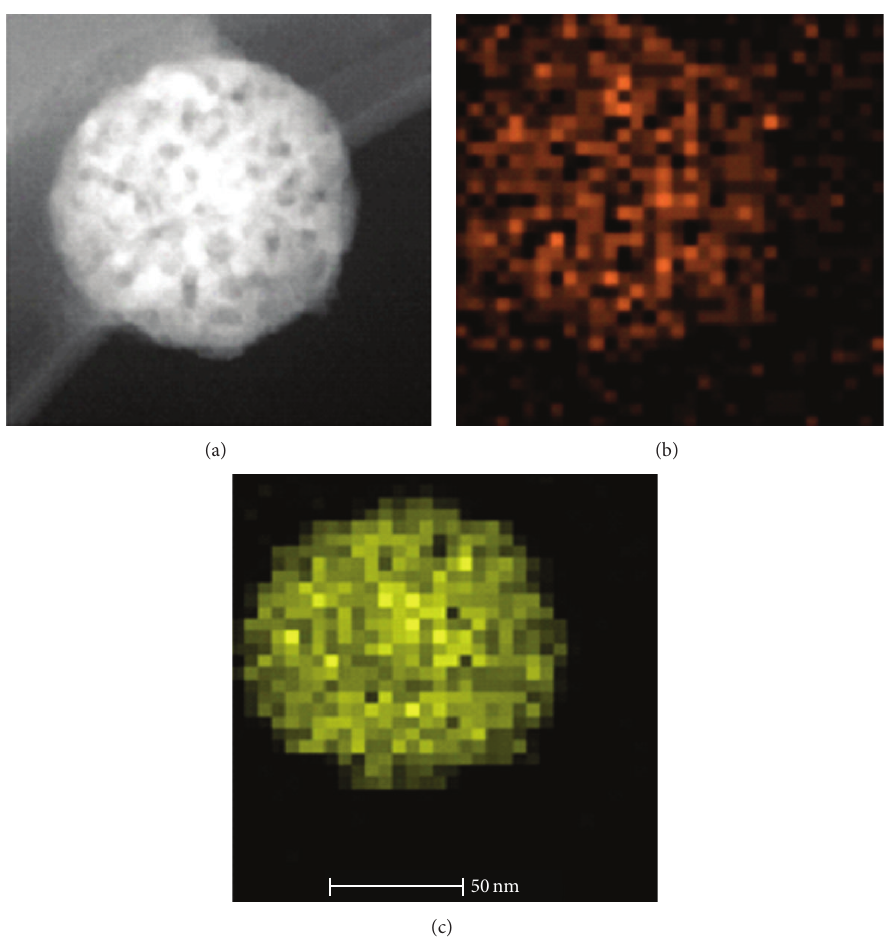
Figure 3: TEM images; (a) TiO 2 nanodots film with Mg doped, (b) Mg element mapping, and (c) Ti element mapping.